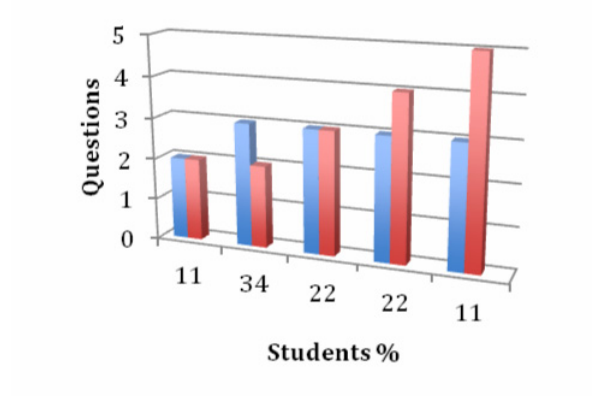
Figure 6. Exam results: questions related to learning methods (blue), other questions